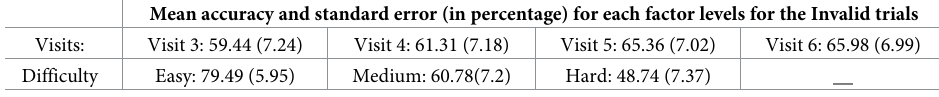
Table 2. Summary of mean accuracy and standard error for the significant main effects. Mean accuracy and standard error (in percentage) for each factor levels for the Invalid trials